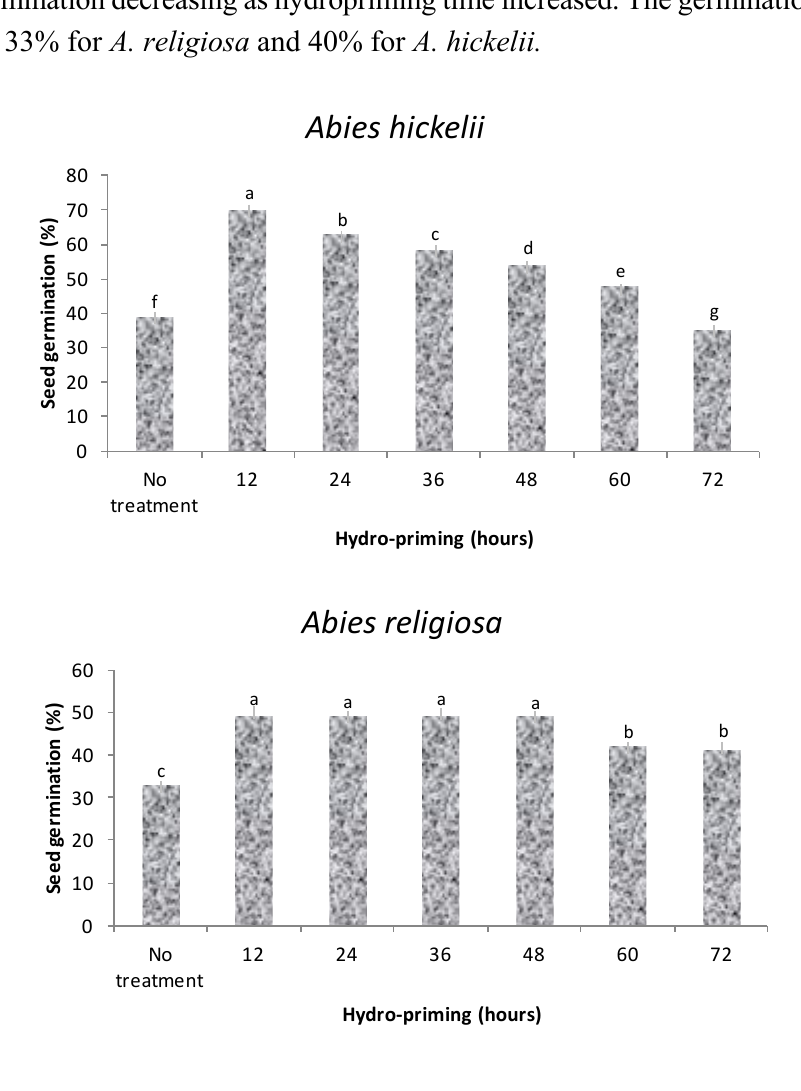
Figure 1. Germination percentage with only hydropriming for seeds of Abies religiosa and A. hickelii. No treatment = Control, only moistened with sterile distilled water.